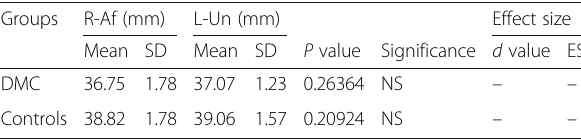
Table 3 Results of statistical comparisons between the right/ affected and left/unaffected